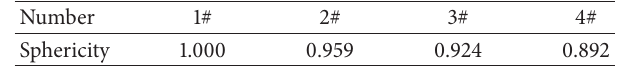
Table 1: Shapes factor of representative